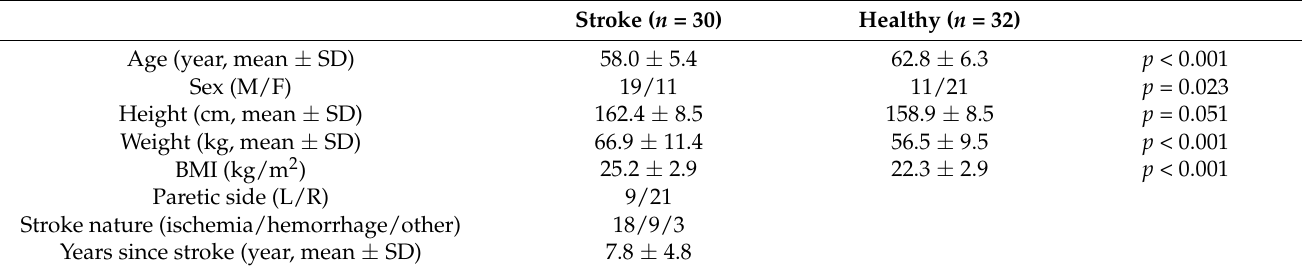
Table 1. Demographics of the subjects.